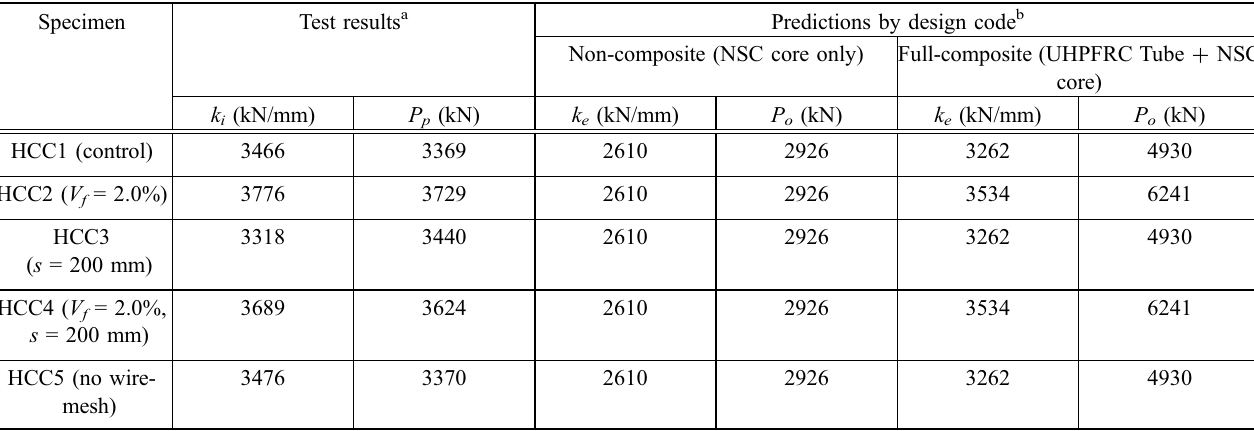
Table 6 Comparison of test results with predictions by design code.